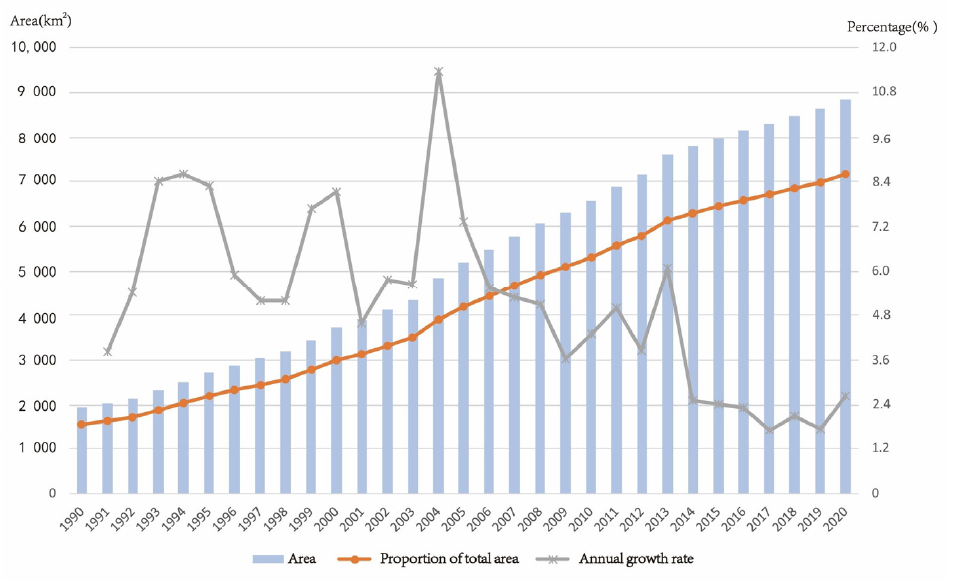
Figure 4. Change in built-up areas from 1990 to 2020. Note: The annual growth rate is the built-up land area of each year minus the preceding year and then divided by the built-up land area of the preceding year.